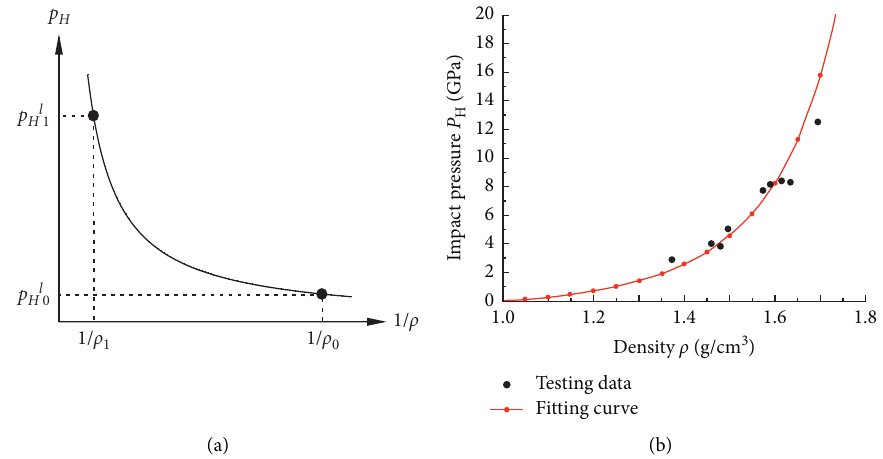
Figure 5: Hugoniot impact pressure curve of water flow: (a) standard Hugoniot impact curve; (b) fitting Hugoniot impact curve.